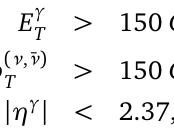
Figure 3: Same as in Fig. 2, but for